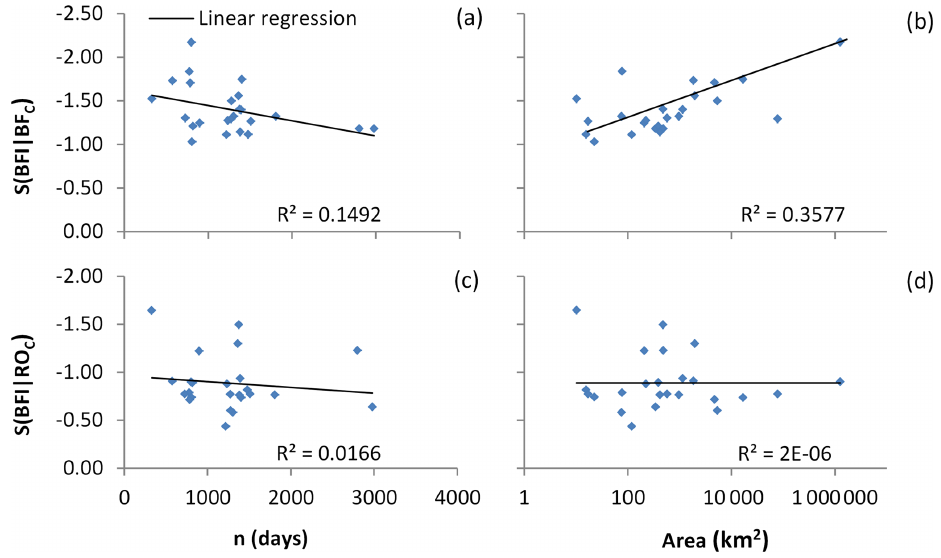
Figure 1. Scatterplots of sensitivity indices vs. time series ( n ) and drainage area of the 24 US basins. The watershed area uses a logarithmic axis, while the others are linear axes.